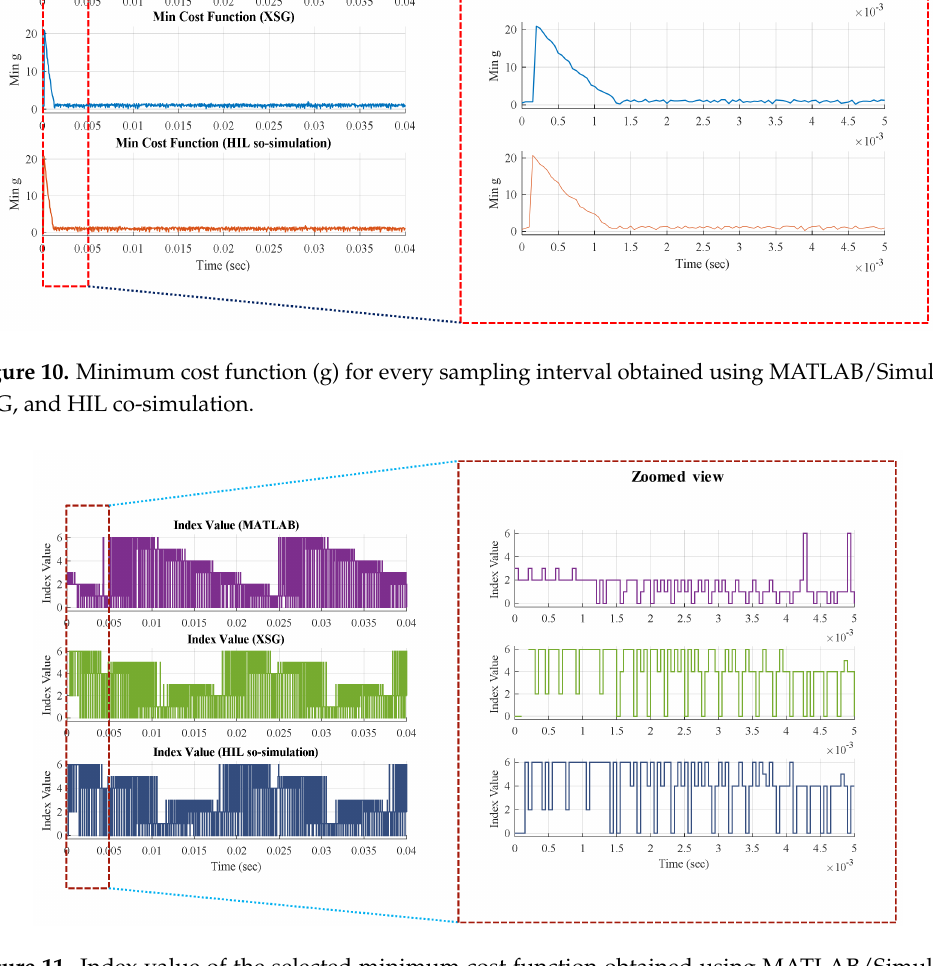
Figure 11. Index value of the selected minimum cost function obtained using MATLAB/Simulink, XSG, and HIL